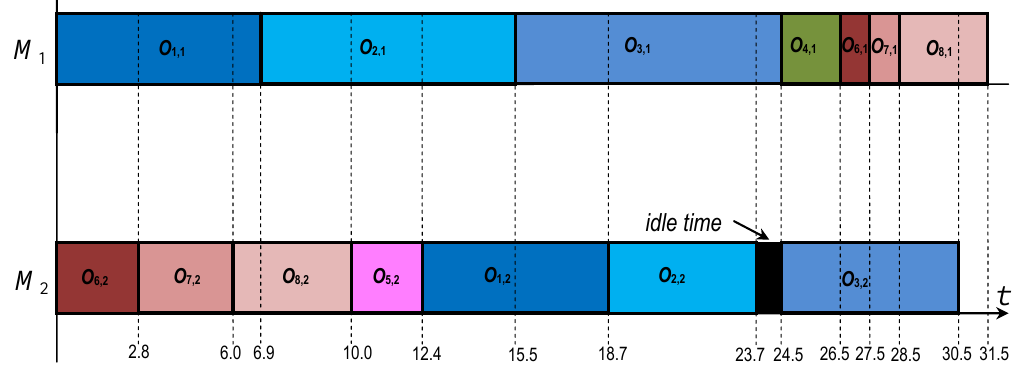
Figure 4. The optimal semi-active schedule for the Example 2 in case